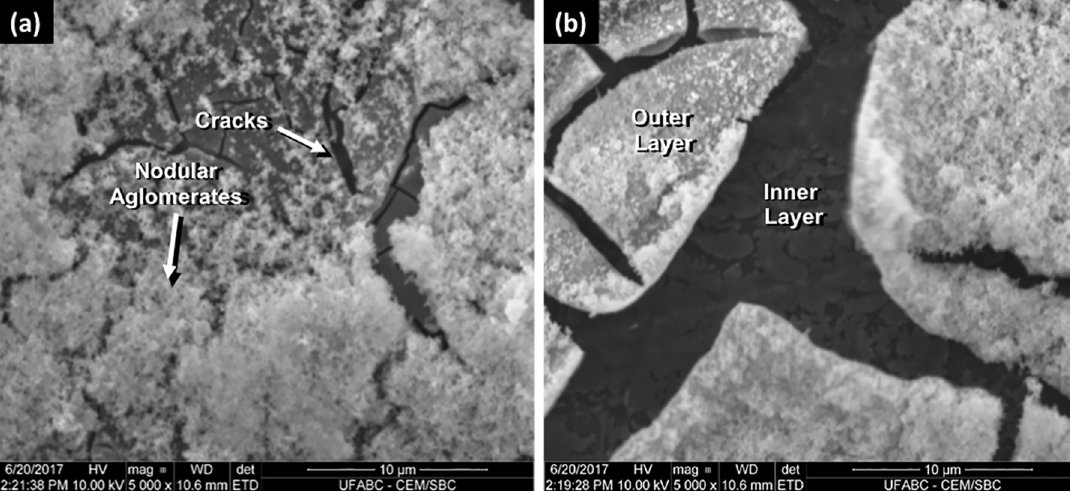
Figure 2. SEM micrographs for the AZ91D alloy in cerium-coated 120